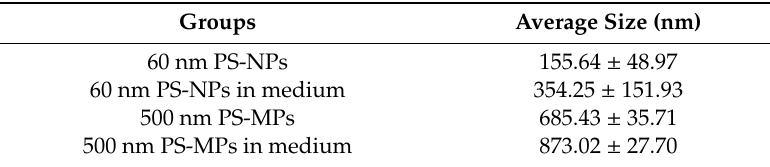
Table 1. The hydrated sizes of PS-NPs and PS-MPs.